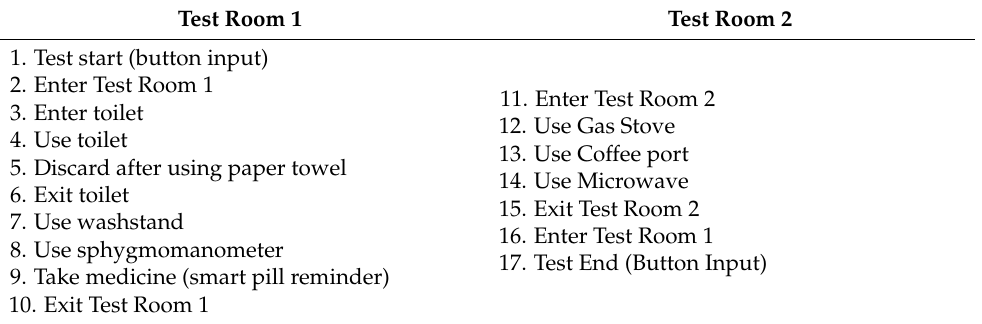
Table 1. ADL Test Configuration and